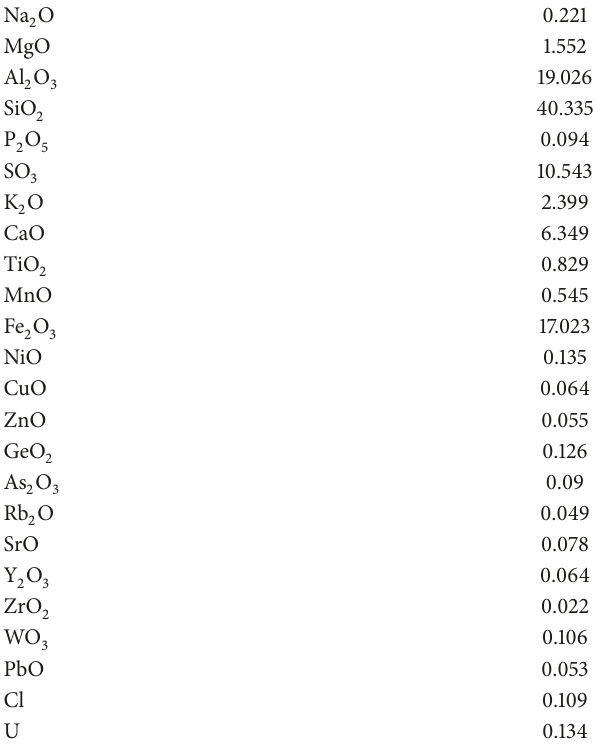
Table 1: Chemical compositions of the lignite (wt.%) (ash